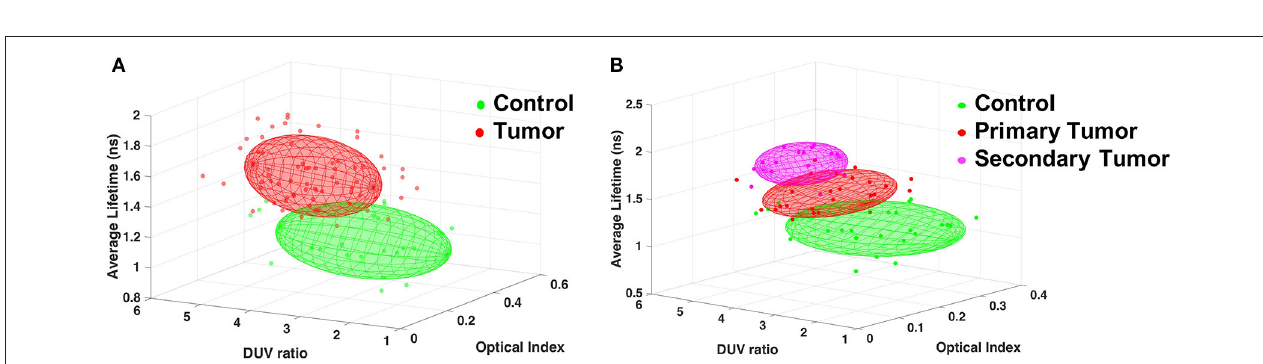
FIGURE 4 | Phasor analysis of the FLIM: (A) Global phasor histogram with the selected zones and the error ellipses. (E) Average lifetime fluorescence decay calculated in each zones. (L) Boxplot of the pixel colors criterion with p -values of the control-tumor test. Comparison of three tissue groups control (B,F,I,M) , glioblastoma (C,G,J,N) and metastasis (D,H,K,O) with rebuilt images of the phasor analysis (B,C,D,I,J) and Fast FLIM of the microscope (F,G,H,M,N,O) .